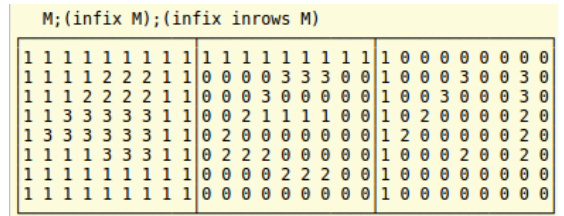
Fig. 5. Transforming a full area grid (left) into a sparse boundary grid by xor infix , either column wise (centre) or row wise (right).